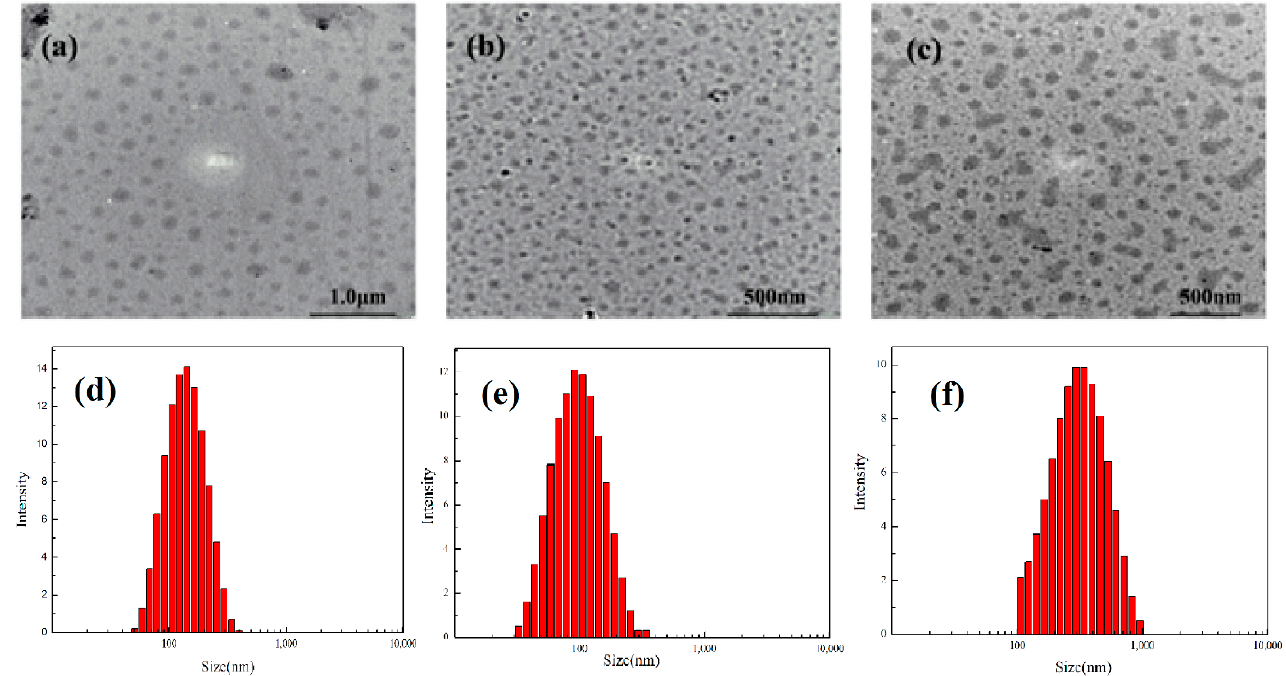
Figure 8. The transmission electron microscope image of nanohydrogel gel1 at 25 °C ( a ), 37 °C ( b ), 25 °C 10 mM DTT( c ), the particle size diagrams of nanohydrogel gel1 at 25 °C ( d ), 37 °C ( e ), 25 °C 10 mM DTT( f ).